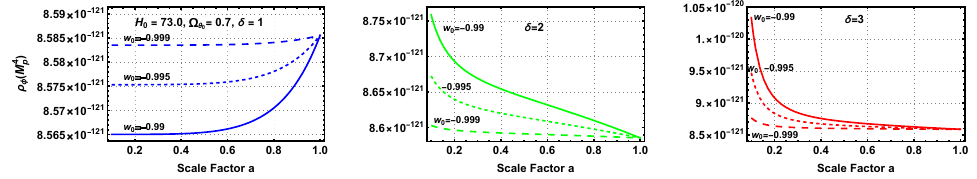
Figure 10. The evolution of the dark energy density for all of the cases in this study. As usual, the δ = 1 evolutions have a different character from the other two. The density evolution for w 0 = − 0.999 is essentially flat, and the highest evolution case, w 0 = − 0.99, only changes by 0.3%. For all values of w 0 , the δ = 1 density has a slight rise near a scale factor of 1. For scale factors less than 0.6, the densities are essentially constant acting like a cosmological constant in the matter-dominated epoch. For δ = 2 and 3, the density is monotonically decreasing with increasing scale factor. The second derivative of the decrease of density for the δ = 2 case changes from negative to positive with increasing scale factor similar to the scalar. The decrease in density for the δ = 3 case is larger than for the other two cases but is still only on the order of 20% for the maximum case. Unlike the δ = 2 case, the second derivative of the evolution is negative at all scale factors. Figure 11 shows the evolution of the dark energy pressure. The dark energy pressures have their characteristic negative values and, although more than the density, the absolute evolution is relatively small. The δ = 1 and 3 evolutions are monotonically positive and negative, respectively, but the δ = 2 pressure evolutions have stronger transitions from negative to positive than the density. As in the dark energy density, the w 0 = − 0.999 evolution is quite flat, as would be expected for a w 0 value so close to −